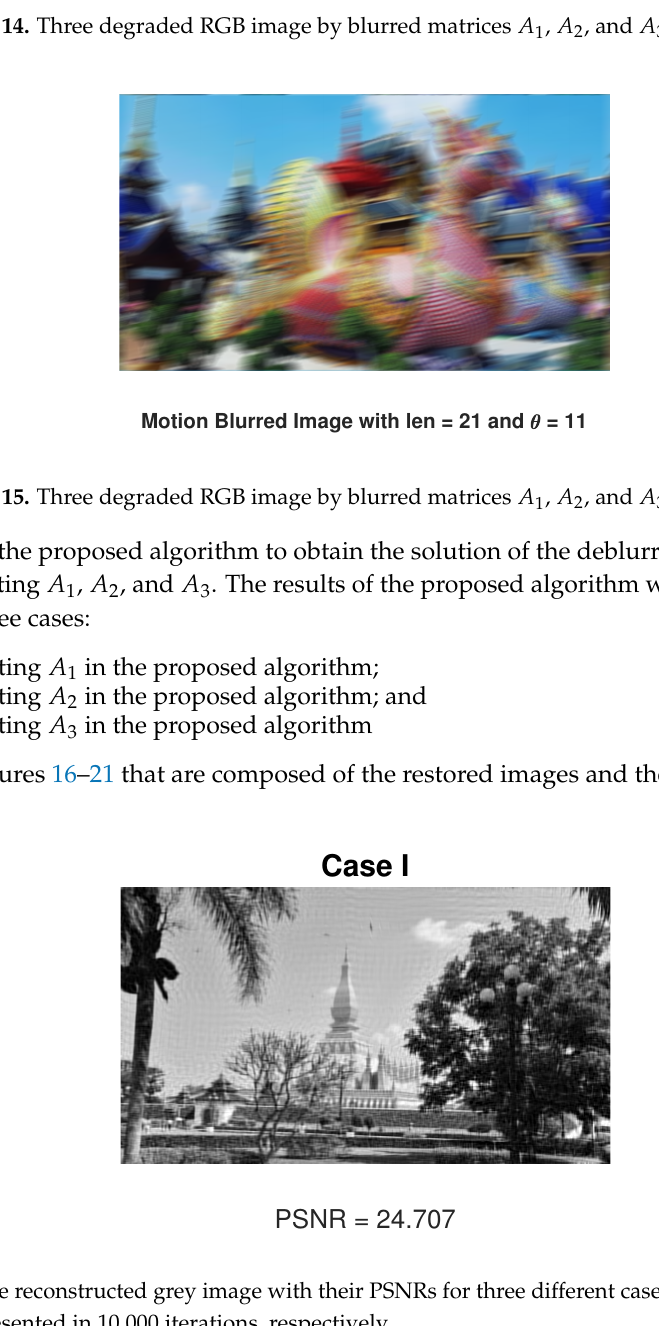
Figure 14. Three degraded RGB image by blurred matrices A 1 , A 2 , and A 3 , respectively.